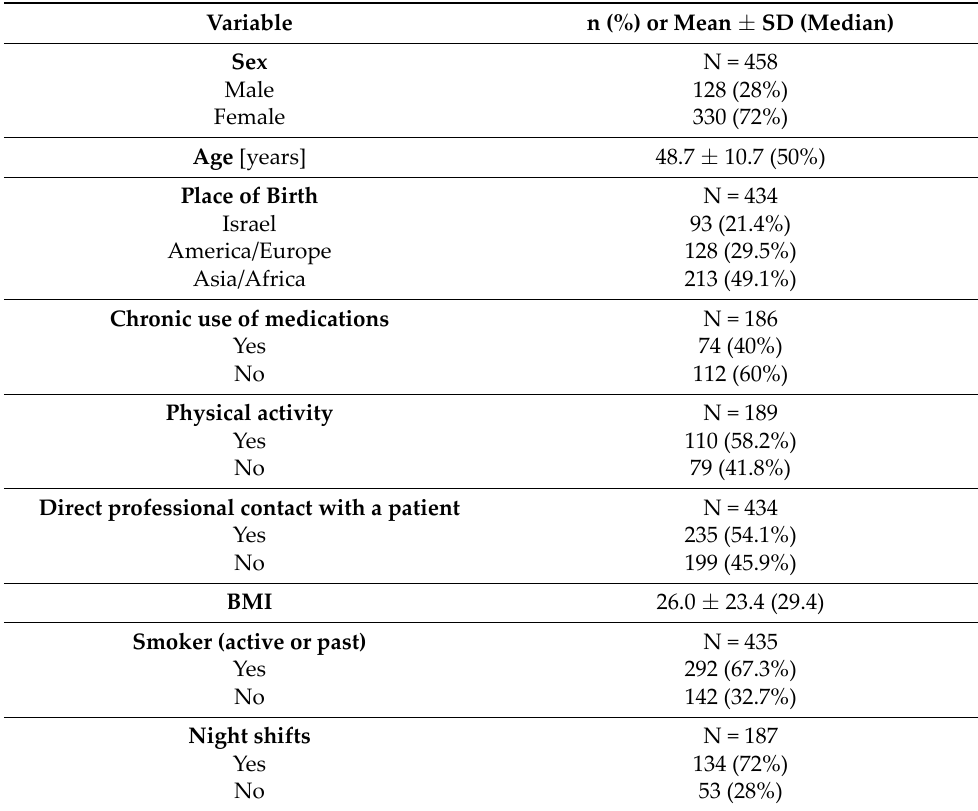
Table 1. Demographic characteristics of the study